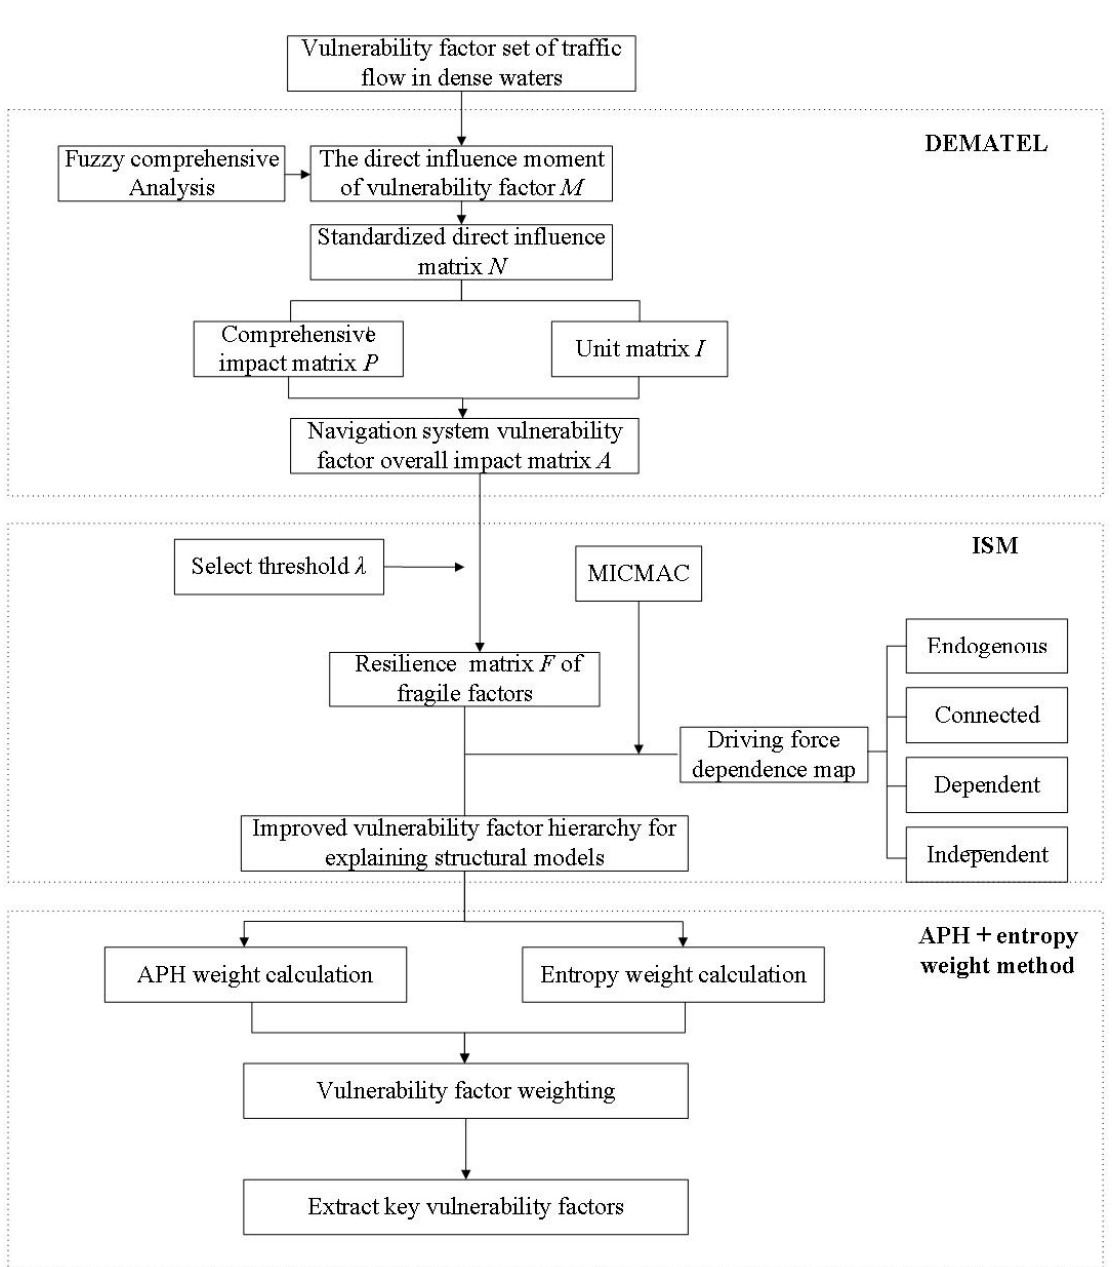
Figure 3. Vulnerability model of a water transportation system in traffic-intensive waters.